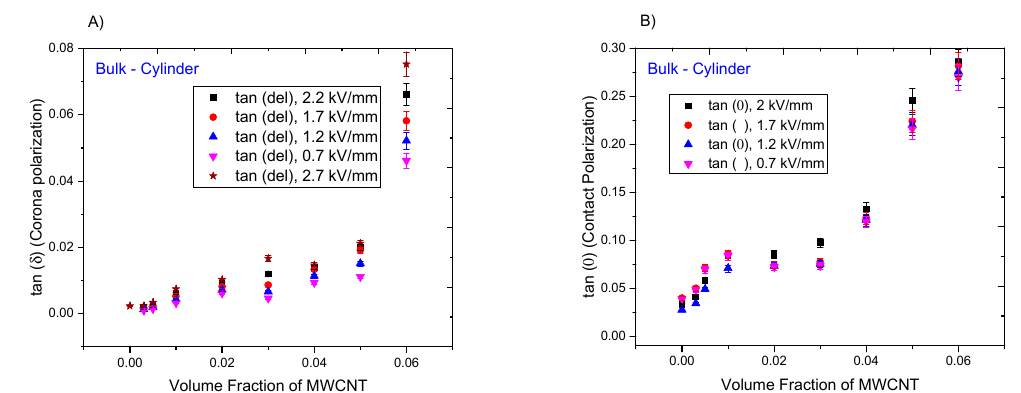
Figure 3. Variation in the dielectric loss, tan δ , as a function of polarization voltage and volume fraction of MWCNT for ( A ) corona and ( B ) contact polarized samples.